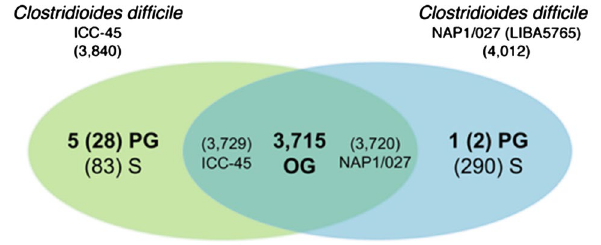
Figure 1. Homology analysis of Clostridioides difficile (formerly Clostridium difficile ) ICC-45 and NAP1/027 (LIBA5756) strains. A total of 3715 orthologous groups (OG) were found between the two strains: 3729 proteins from C. difficile ICC-45 and 3720 from C. difficile NAP1/027 (LIBA5756). C. difficile ICC-45 has 3840 identified proteins, five paralogous groups (PG) with 28 proteins, and 83 singletons (S). C. difficile NAP1/027